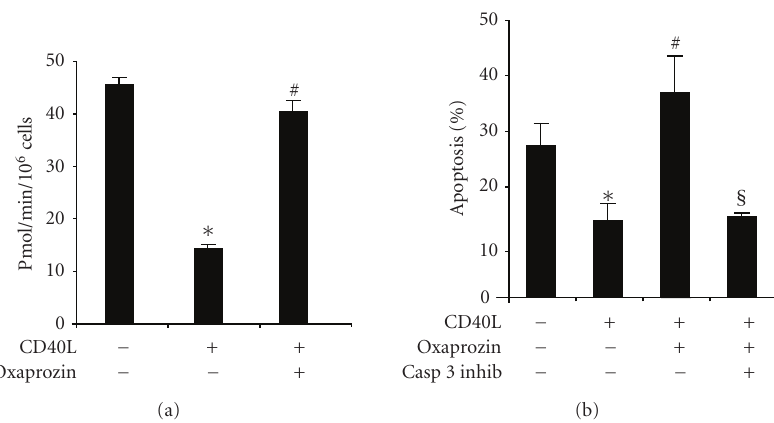
Figure 4: Oxaprozin-induced apoptosis of CD40L-treated monocytes involves the activation of caspase 3 . (a) Monocytes were cultured for 48 hours with control medium or 200 ng/mL CD40L plus 1 μ g/mL CD40L enhancer in the presence or absence of 100 μ M of oxaprozin. Then cells were lysed, and caspase 3 activity was determined by spectrophotometer. Data are expressed as mean ± SEM, n = 3. (caspase 3 activity in absence versus in presence of CD40L: ∗ P < .05; caspase 3 activity in presence of CD40L versus CD40L plus oxaprozin: # P < .05). (b) Monocytes were incubated for 48 hours with control medium or 200 ng/mL CD40L plus 1 μ g/mL CD40L enhancer in the presence or absence 100 μ M of oxaprozin and 50 μ M Ac-DEVD-CHO (caspase 3 inhibitor, CASP 3 INHIB). Data are expressed as mean ± SEM, n = 3 (apoptosis in absence versus in presence of CD40L: ∗ P < .05; apoptosis in presence of CD40L versus CD40L plus oxaprozin: # P < .05; apoptosis in presence of CD40L plus oxaprozin versus CD40L plus oxaprozin and caspase 3 inhibitor: § P < .05).